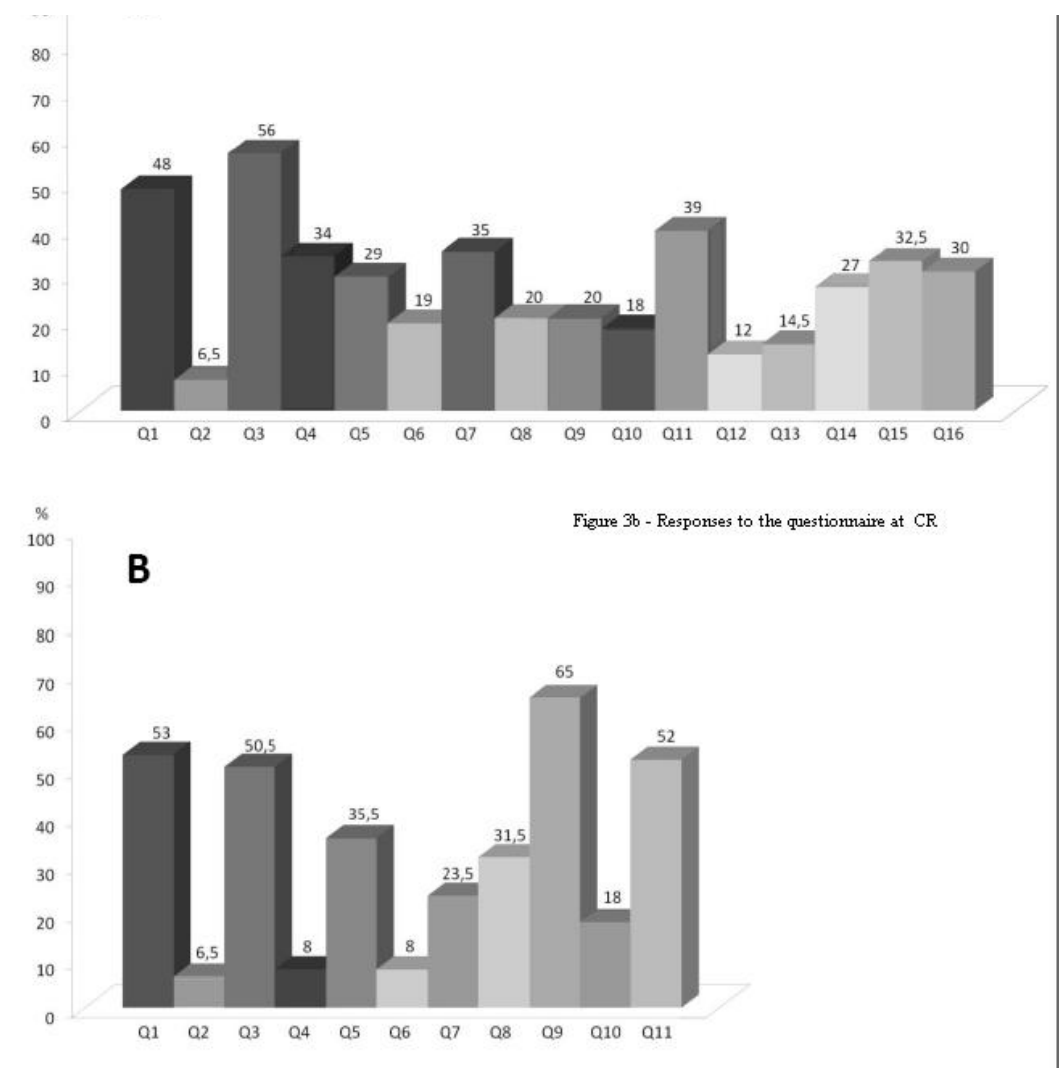
Figure 3 . A: Responses to the questionnaire in DH (Day Hospital) B: Responses to the questionnaire in CR (Consultation Rooms)